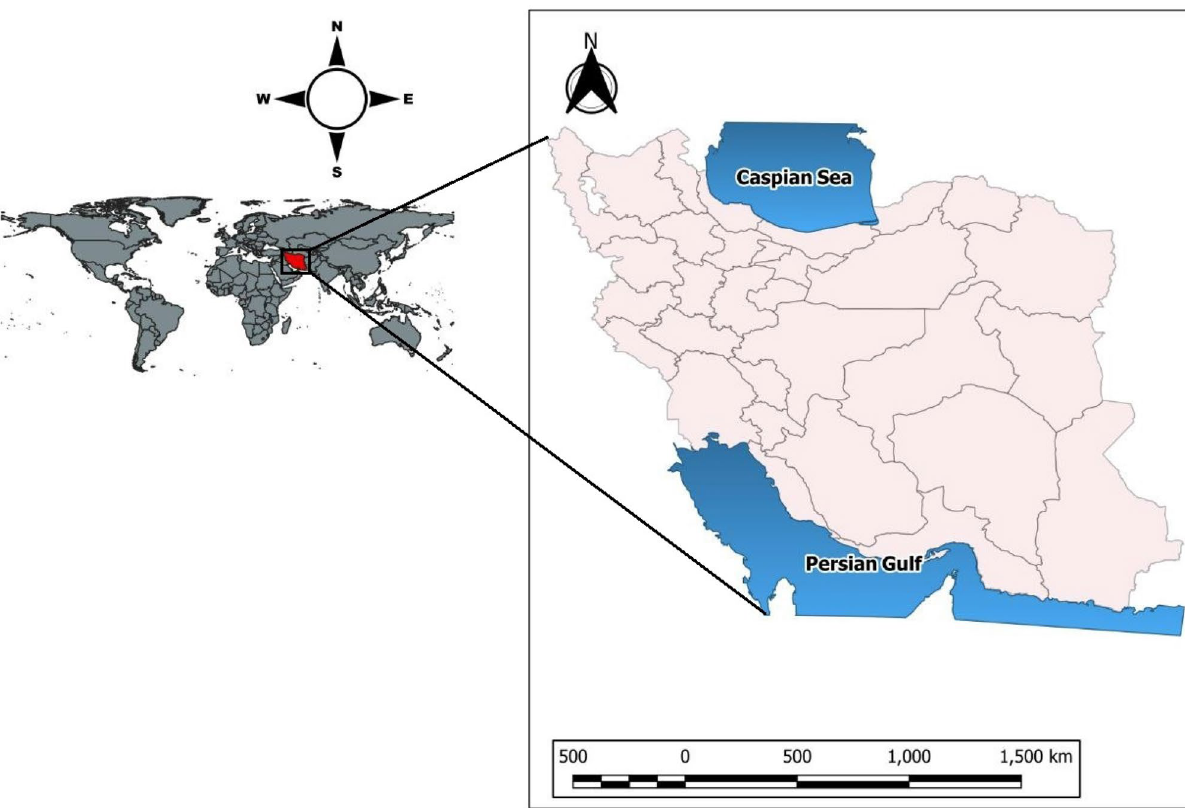
Figure 3. Iran country